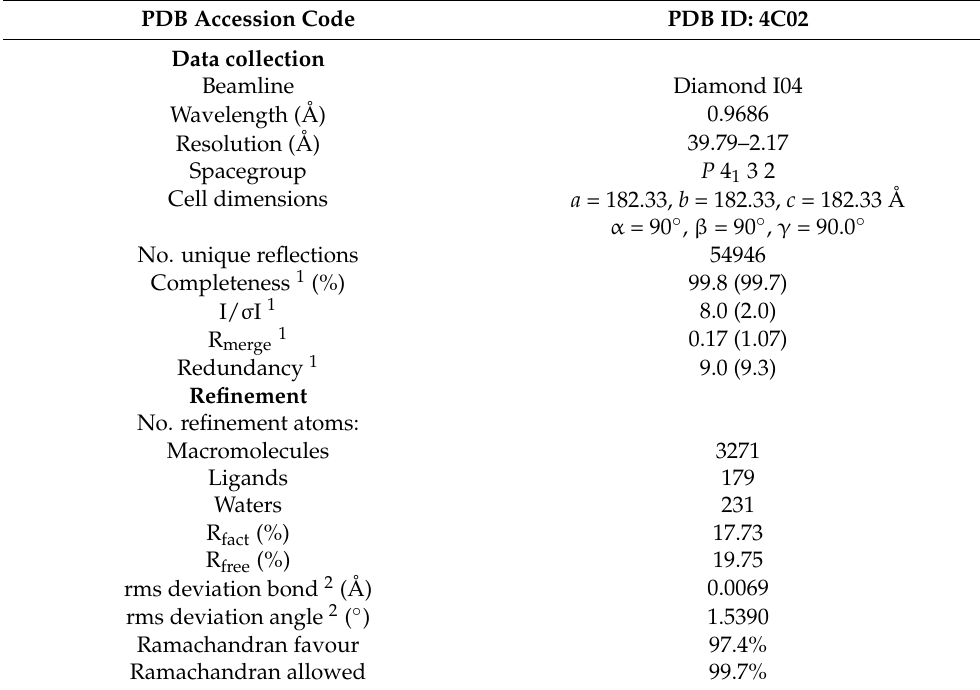
Table 1. Diffraction data and refinement